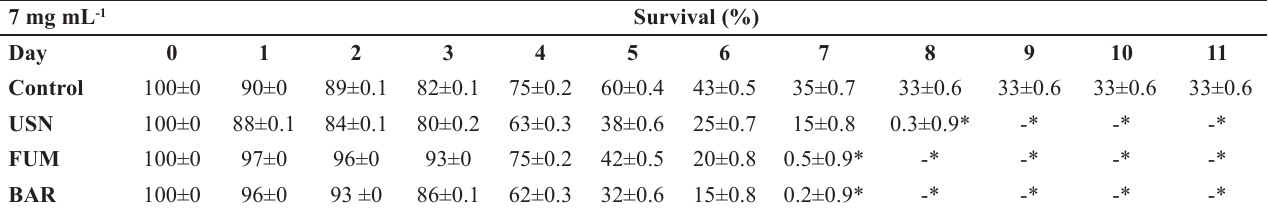
Table 2 . Percentage of termite worker survival following treatment with usnic (USN), fumarprotocetraric (FUM) and barbatic (BAR) acids at concentration of 7 mg ml -1 . Symbol (-) indicates 0% survival. Treatments were compared with the control and among treatments. Asterisk (*) indicates a significance difference at p< 0.05.